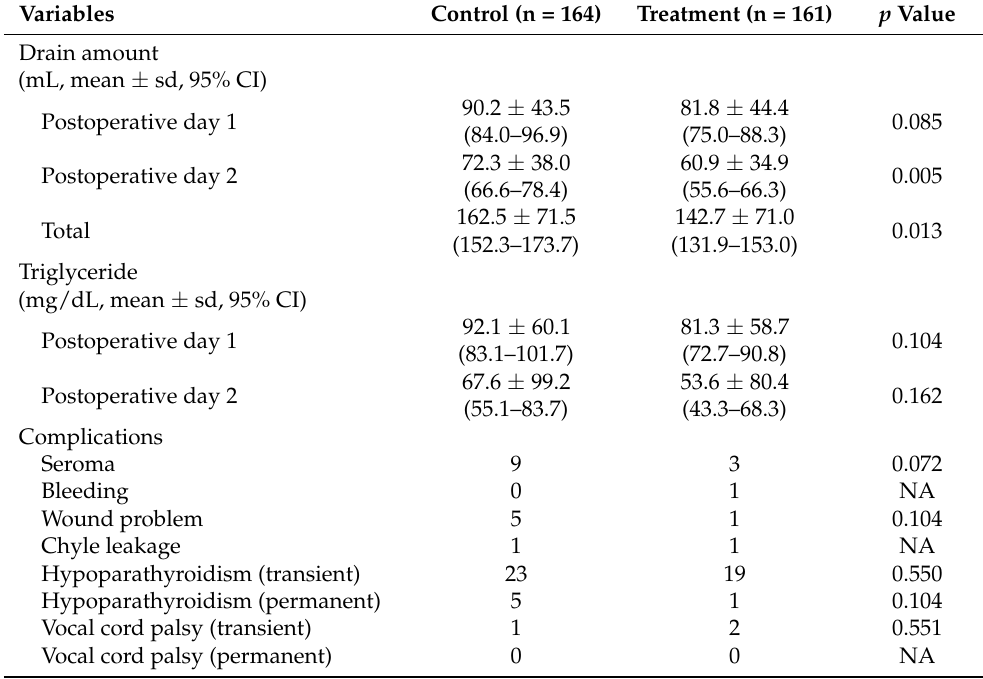
Table 3. Postoperative